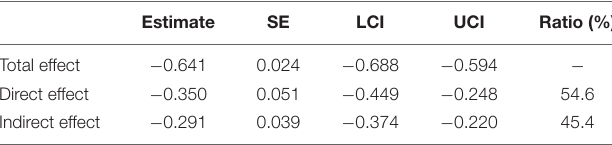
TABLE 3 | The mediating effect test result.